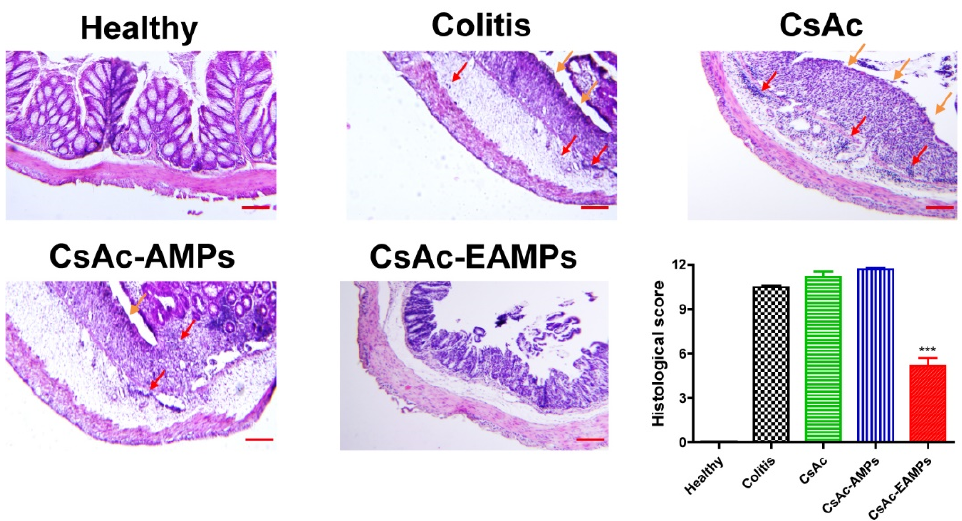
Figure 5. Representative histological images and histological scores of the colon, treated with or without CsA formulations. Orange and red arrows indicate damaged epithelium and infiltrated immune cells, respectively. Scale bar represents 200 µ m. *** denotes p < 0.001 compared with the untreated colitis group. Data are expressed as means ± standard deviation ( n = 3). CsAc, cyclosporine A crystals; CsAc-AMPs, CsA crystal-loaded alginate microparticles; CsAc-EAMPs, CsA crystal-loaded, Eudragit S 100 coated alginate microparticles.